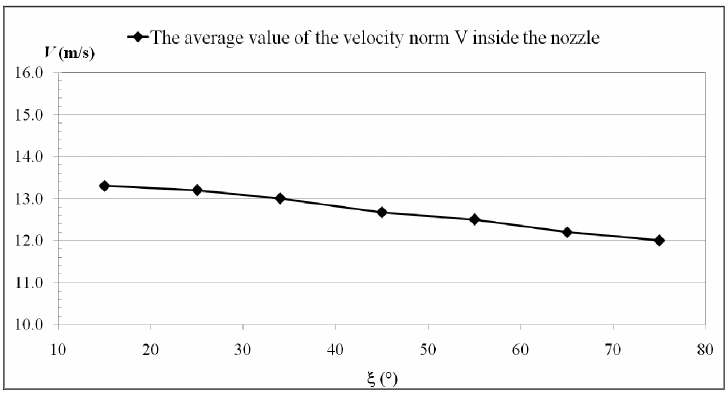
Figure 12. The average value of the velocity norm V inside the